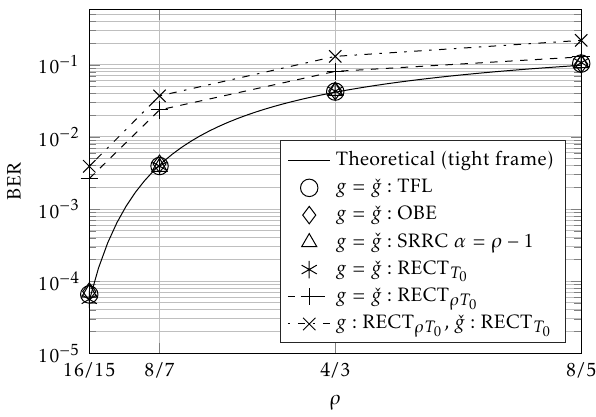
Figure 4. BER as a functionof ρ , with E